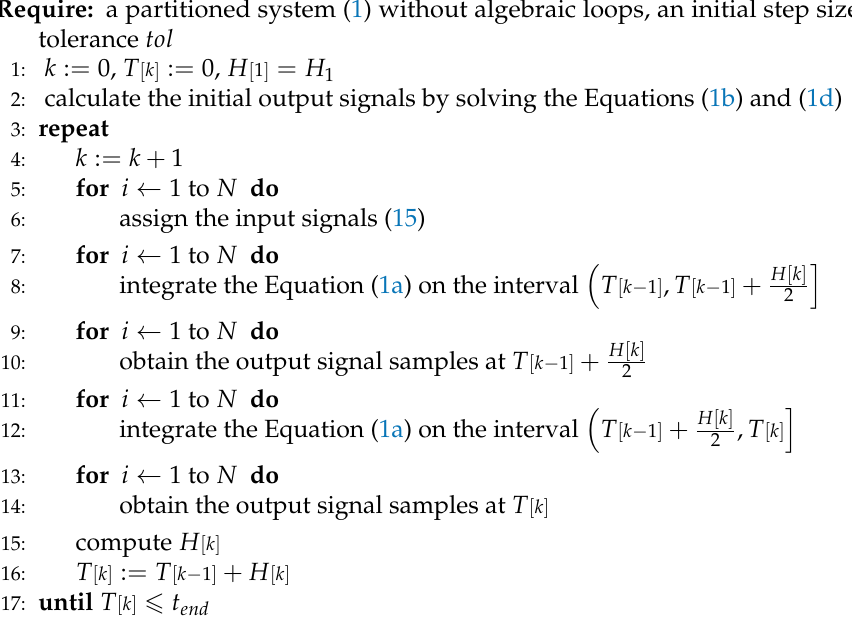
Algorithm 1 The pseudocode describes a non-iterative Jacobi co-simulation method. In the variable-step variant, the step size H [ k ] is computed with the PI controller (17), (32), (38) and (39). In the fixed-step variant, the step size is constant H [ k ] = H [ k − 1 ] = H 1